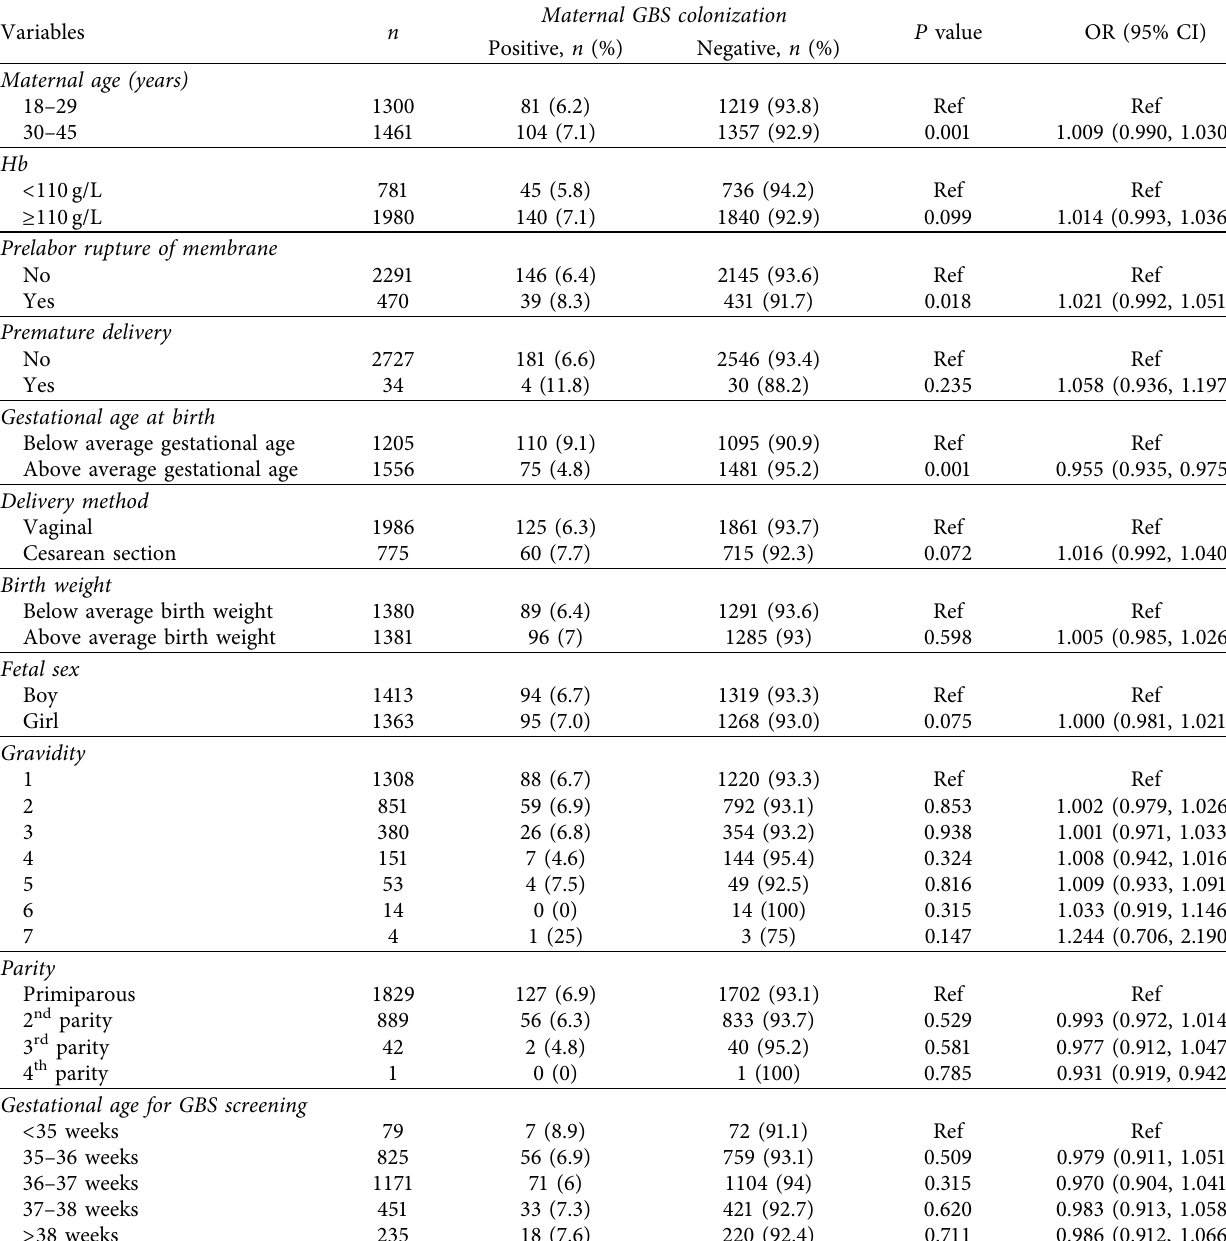
Table 1: Demographic data and associations between risk factors and GBS colonization in pregnant women with gestation of > 34 weeks. Variables